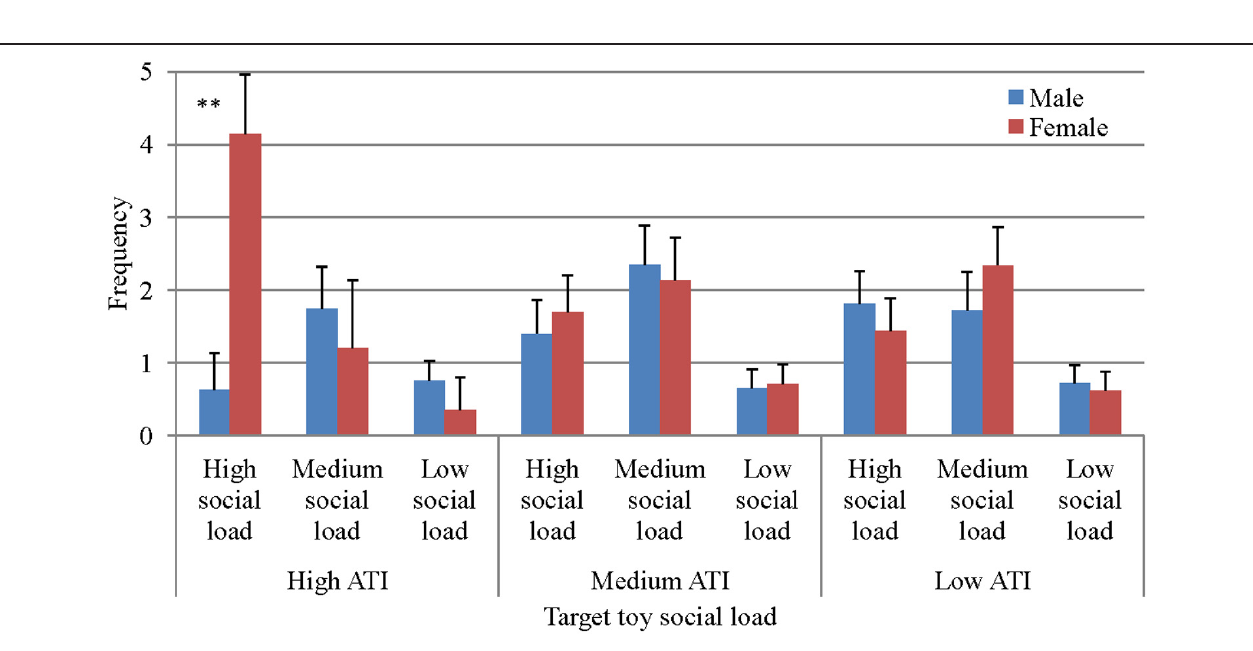
FIGURE 2 | JABS frequency as a function of gender, ATI, and social load (SL). ∗∗ p < 0 .